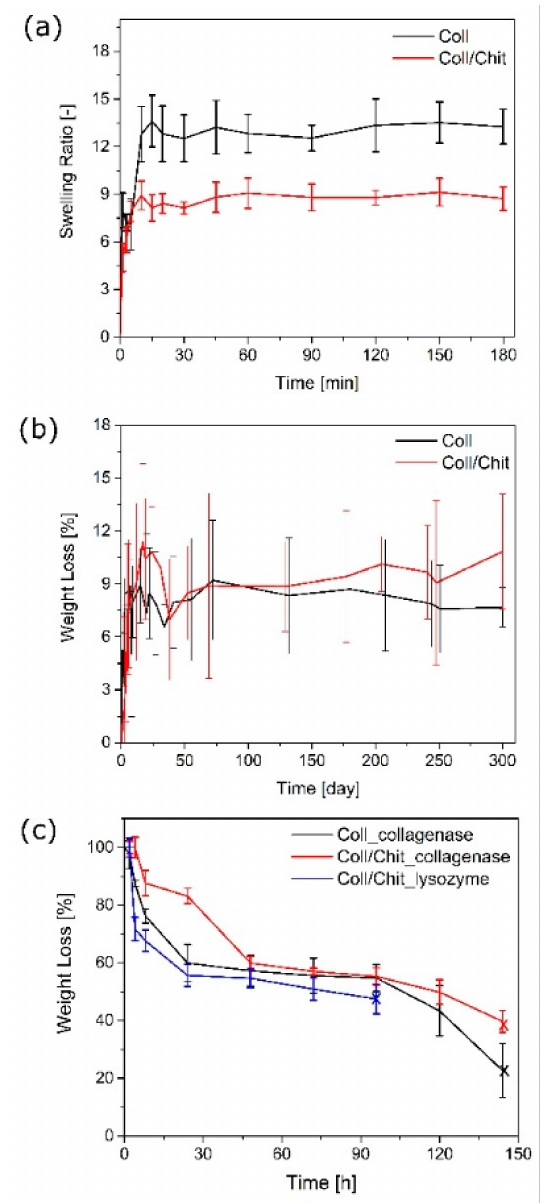
Figure 2. ( a ) Swelling behavior of Coll and Coll/Chit composite scaffold; ( b ) the dependence of the weight loss on the degradation time for Coll and Coll/Chit sponges; ( c ) mass loss of Coll and Coll/Chit scaffolds during the process of enzymatic degradation in PBS solution of either collagenase or